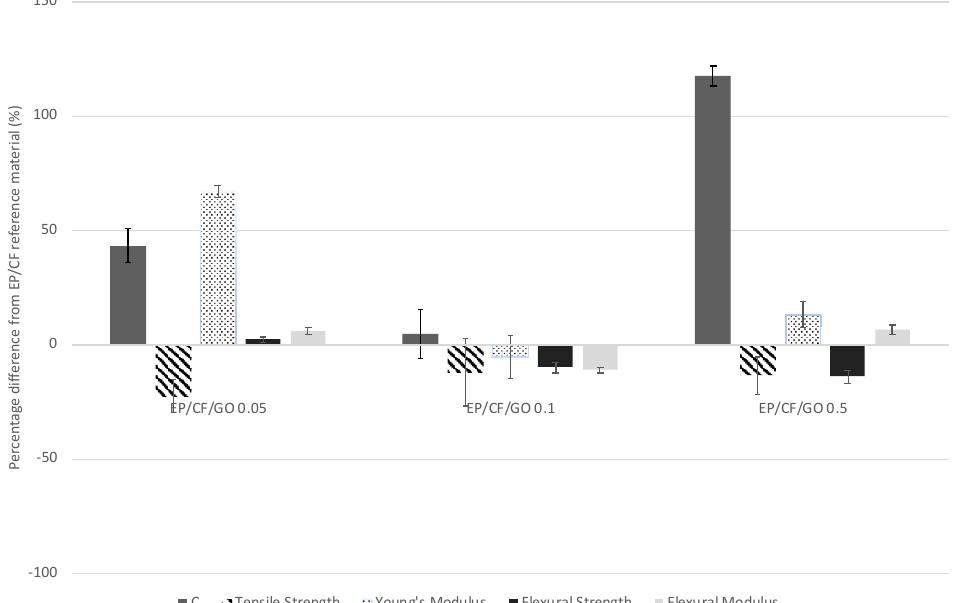
Figure 12. Comparison of percentage difference to neat EP/CF and therefore, the influence of GO within EP/CF-based samples on particle number concentration (C), tensile strength, Young’s modulus, flexural strength and flexural modulus (Note high standard deviations are observed due to the combined deviations of each sample and EP/CF).